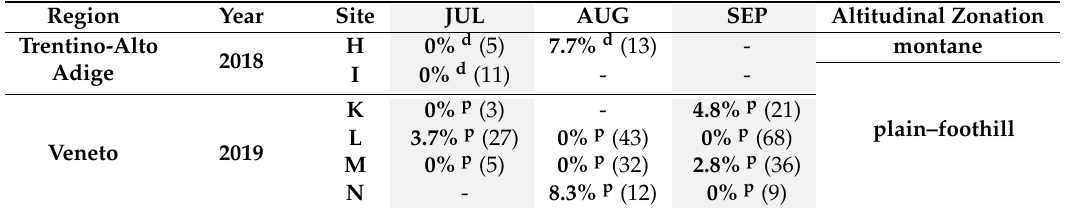
Table 4. Monthly prevalence (%) of Verrallia aucta in samples of Philaenus spumarius collected in northeastern Italian regions during summer 2018 and 2019 (sample size in brackets).